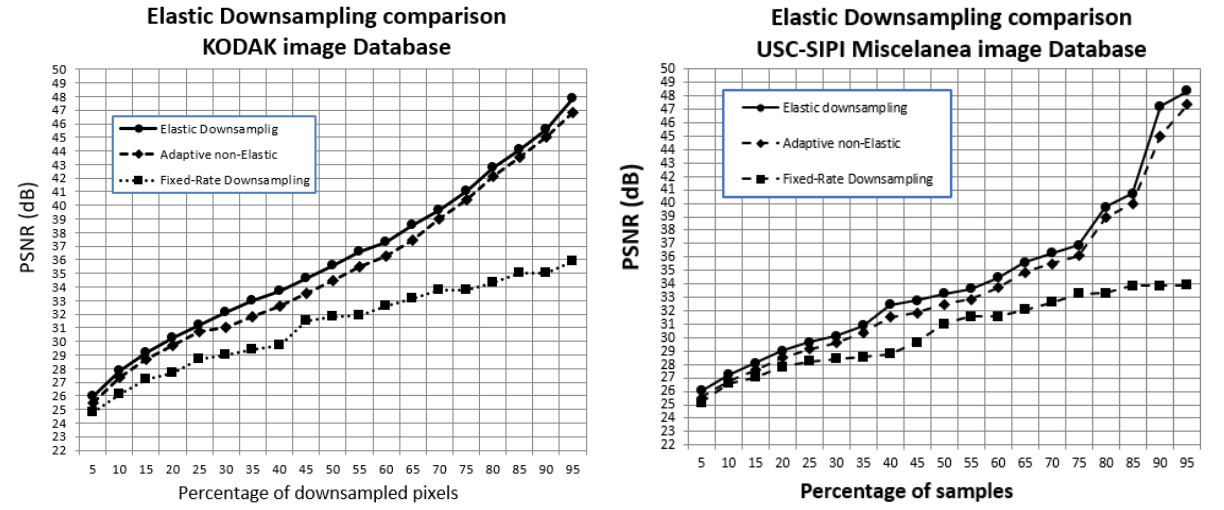
Figure 11. Elastic downsampling distortion diagram comparison. Regarding the SSIM metric, a comparison between adaptive nonelastic and elastic downsampling (Figure 12) reveals very similar curves, slightly better with elastic down- sampling, but not as significant as with the PSNR metric.